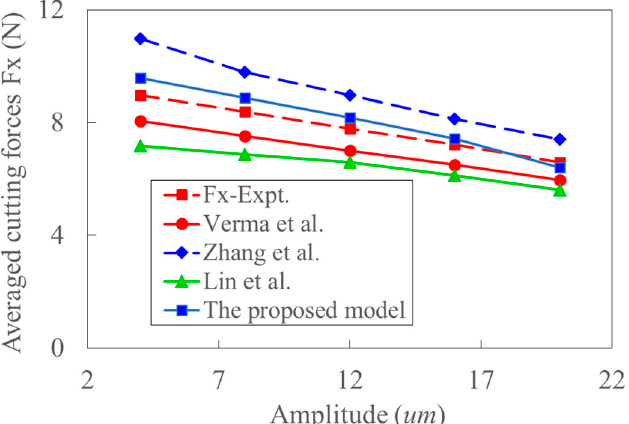
Figure 21. The comparison of predicted and experimental averaged cutting force with the increase of ultrasonic vibration amplitude (Feed rate: 50 mm/min, Cutting depth: 0.6 mm, RPM: 1875).